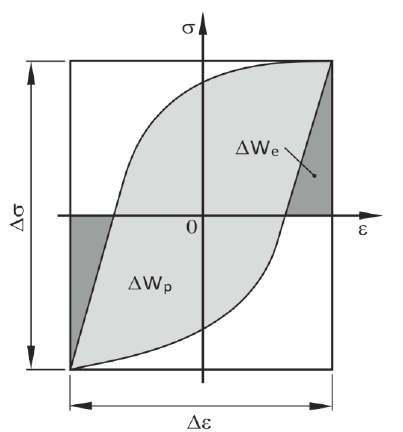
Figure 1. Graphical definition of elastic strain energy density (darker grey areas) and plastic strain energy density (light grey area) considered in the calculations. Table 1. Chemical compositions of tested steels (wt%) (Data from [6]).